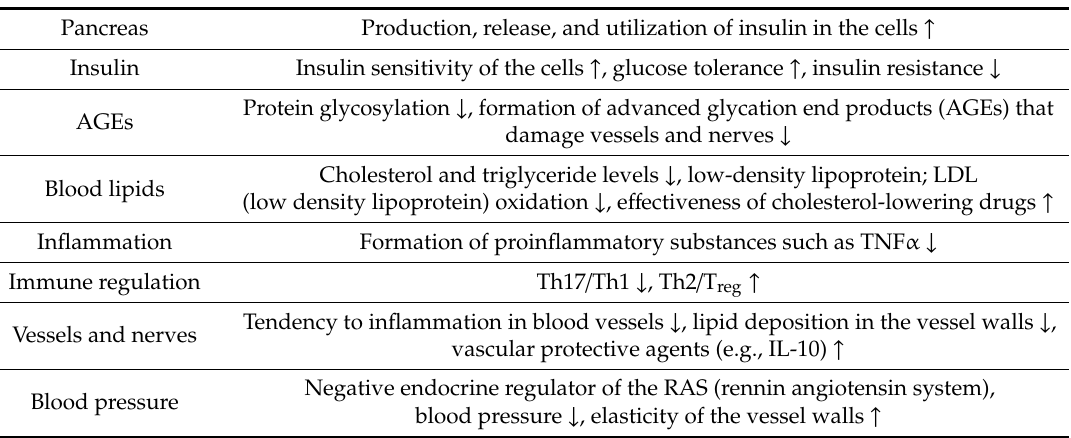
Table 1. E ff ects of 1,25(OH) 2 D on insulin and glucose metabolism (in vivo, in